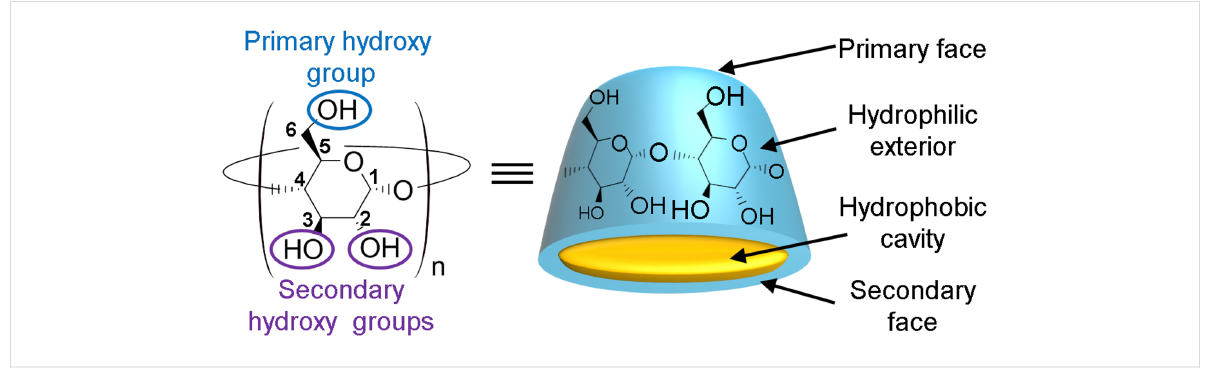
Scheme 1: Structure and conventional representation of native